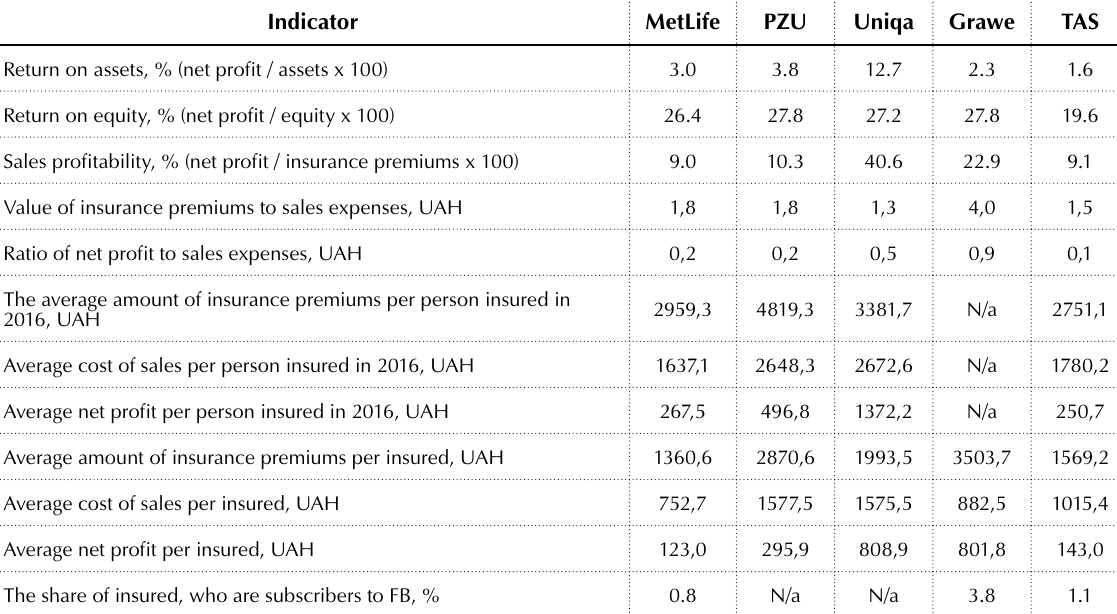
Source: Sites of the companies.